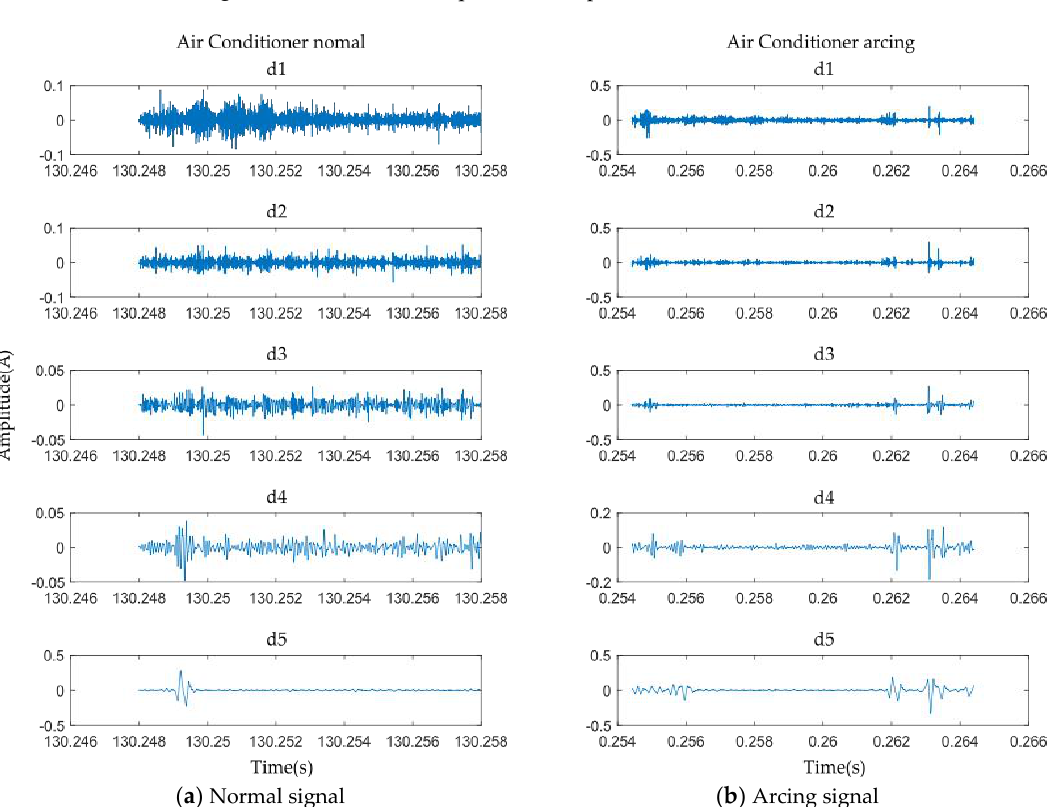
Figure 11. Wavelet decomposition comparison of an air conditioner.